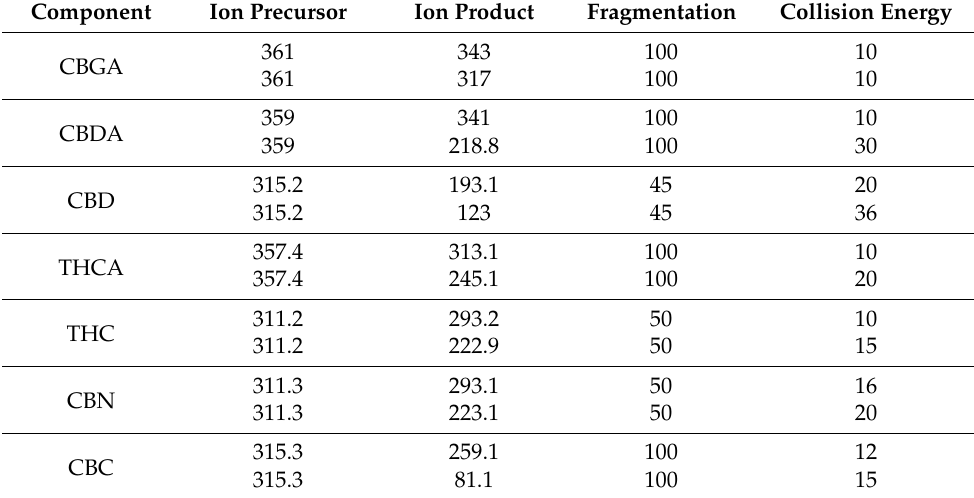
Table 6. Mass spectrometer parameters for LC-MS/MS analysis of